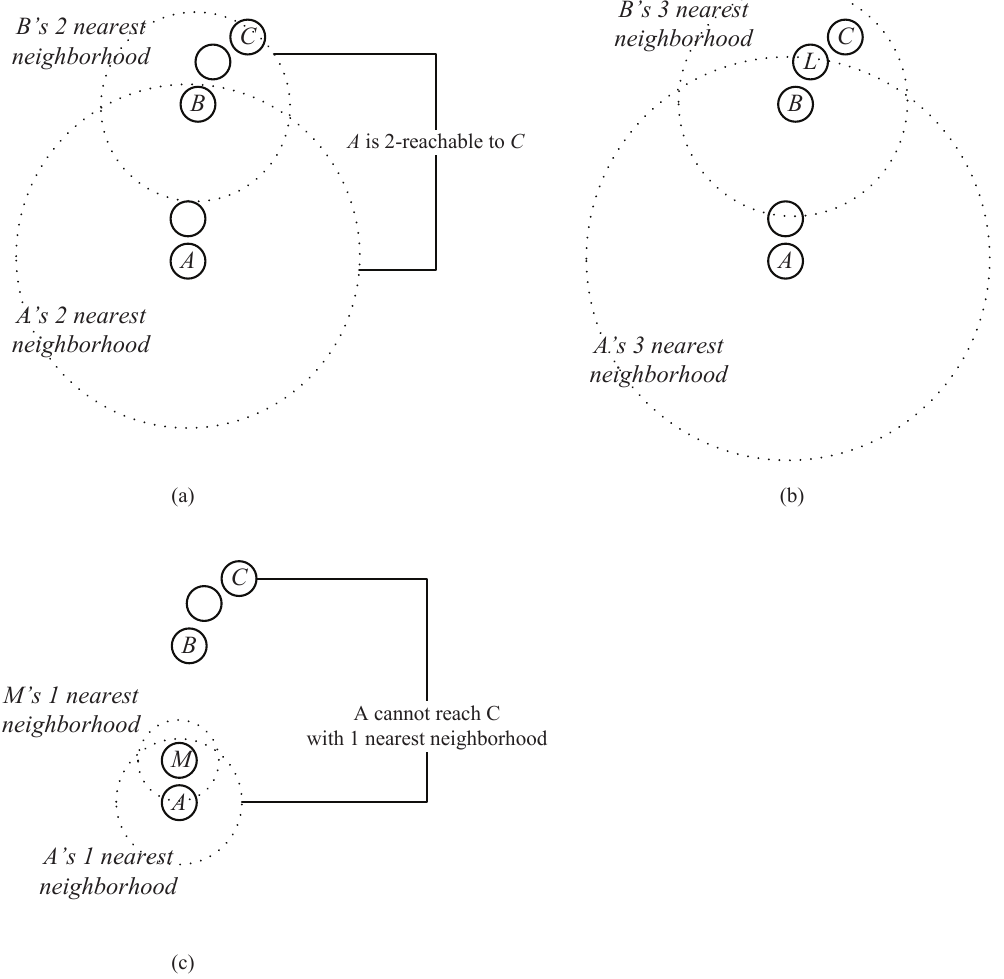
Figure 4. ( a ) A can reach C based on two nearest neighbors. ( b ) A can also reach C based on three nearest neighbors. ( c ) A cannot reach C based on one nearest